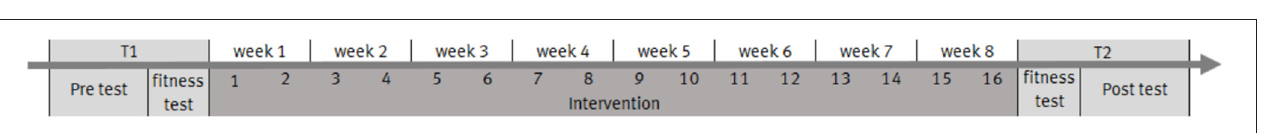
FIGURE 2 | Temporal overview of intervention and test design.